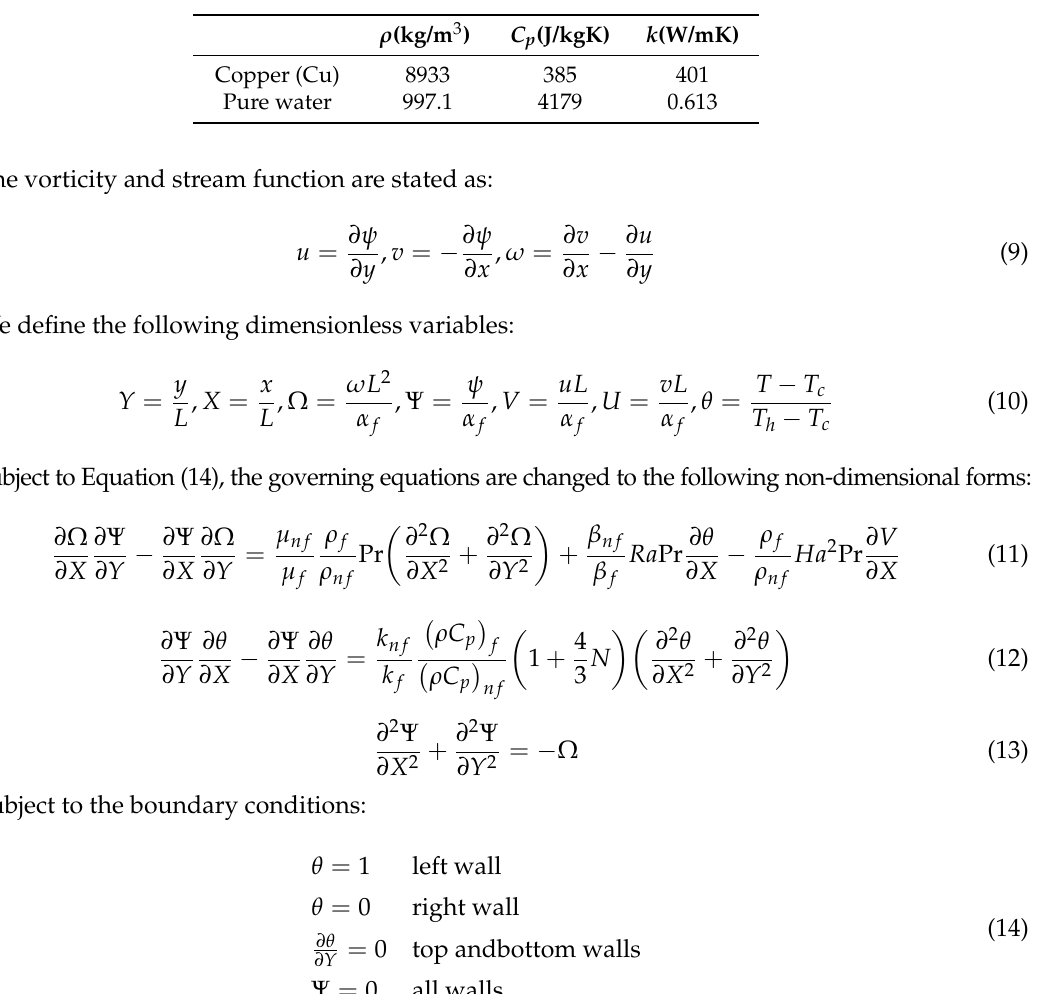
Table 2. Thermophysical properties of water and nanoparticle